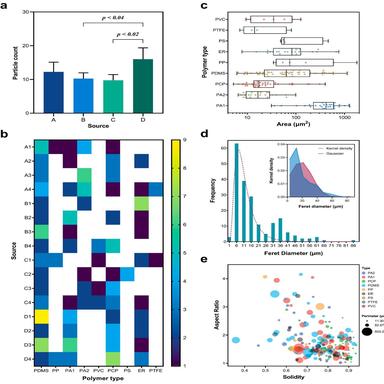
Distribution of detected MPs from IV fluid delivery system. (a) The quantitative representation of MP particle count originating from various source types (A = A1-A4, B = B1-B4, C=C1-C4, D=D1-D4). The mean value is shown by each bar, while the standard deviation is depicted by the whiskers. The data was obtained by calculating the mean of four samples for each set of sources. (b) Heatmap illustrating the distribution of polymer types among MPs based on their respective sources. Empty boxes indicate the abse